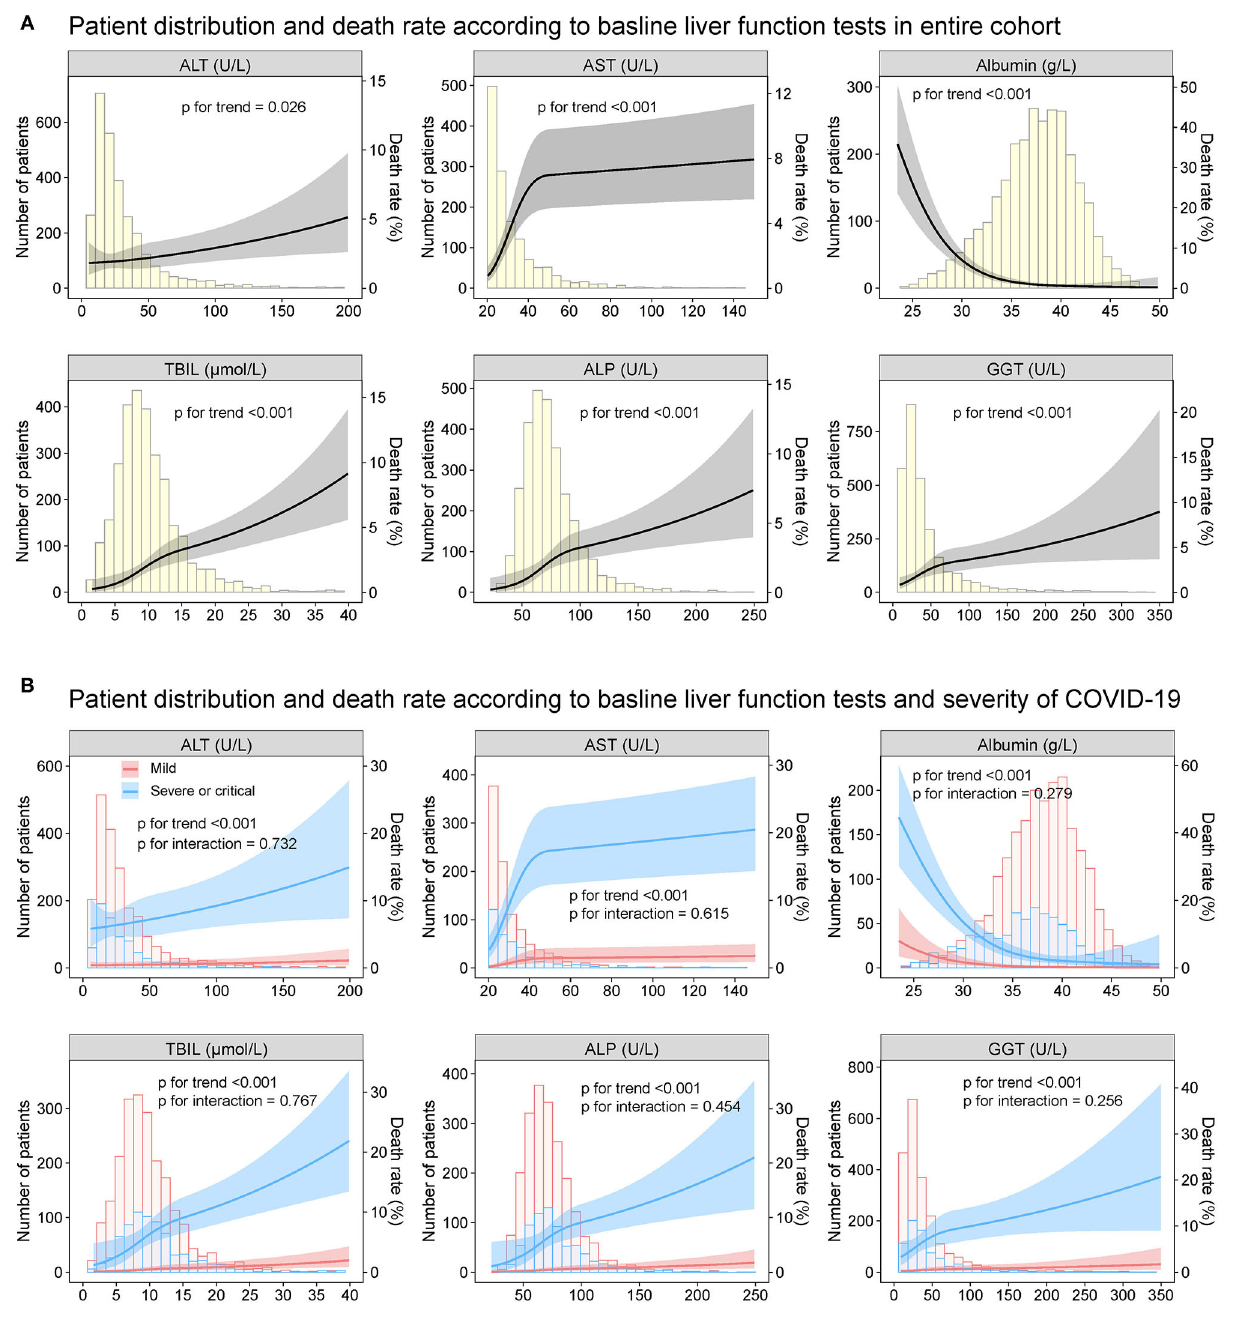
FIGURE 7 | Patient distribution and death rate according to baseline liver function tests Patient distribution and death rate according to baseline ALT, AST, albumin, TBIL, ALP, and GGT (A) in entire cohort and (B) by severity of COVID19 infection (mild vs. severe/critical). Restricted cubic splines were generated using logistic regression models. ALT, alanine aminotransferase; AST, aspartate transaminase; ALP, alkaline phosphatase; GGT, gamma-glutamyltransferase; TBIL, total bilirubin abnormal.